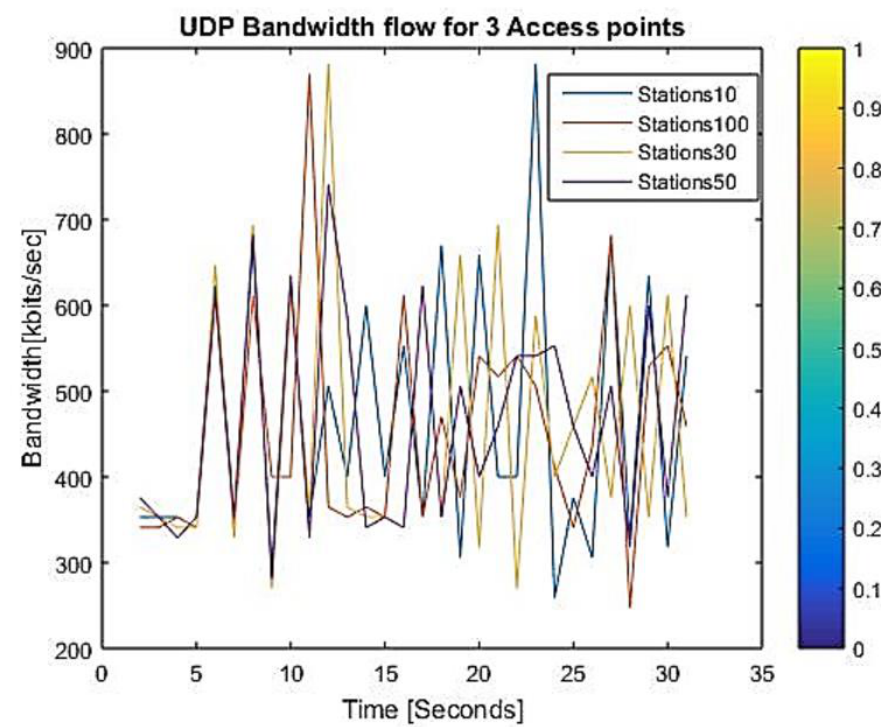
Figure 12. UDP bandwidth for 3 access points.